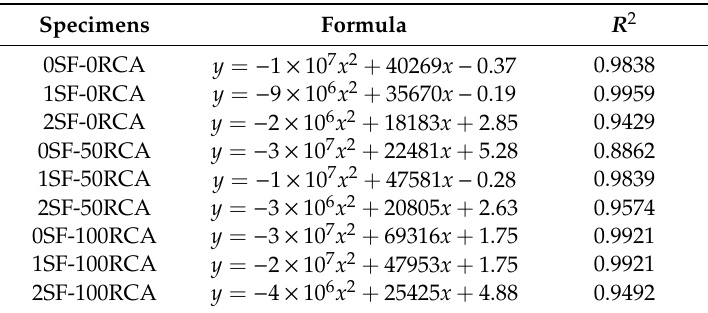
Table 4. Stress-strain formulas for di ff erent SF reinforced RCARC.